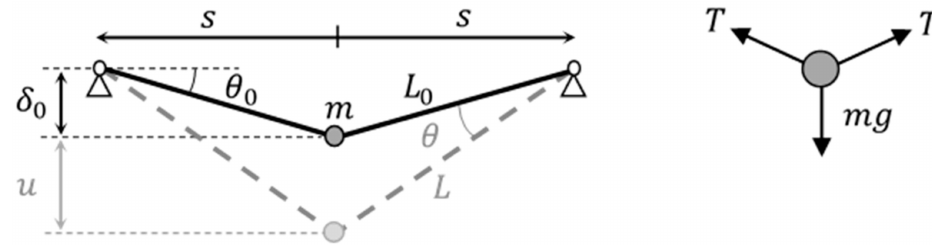
Figure 2. Modified catenary